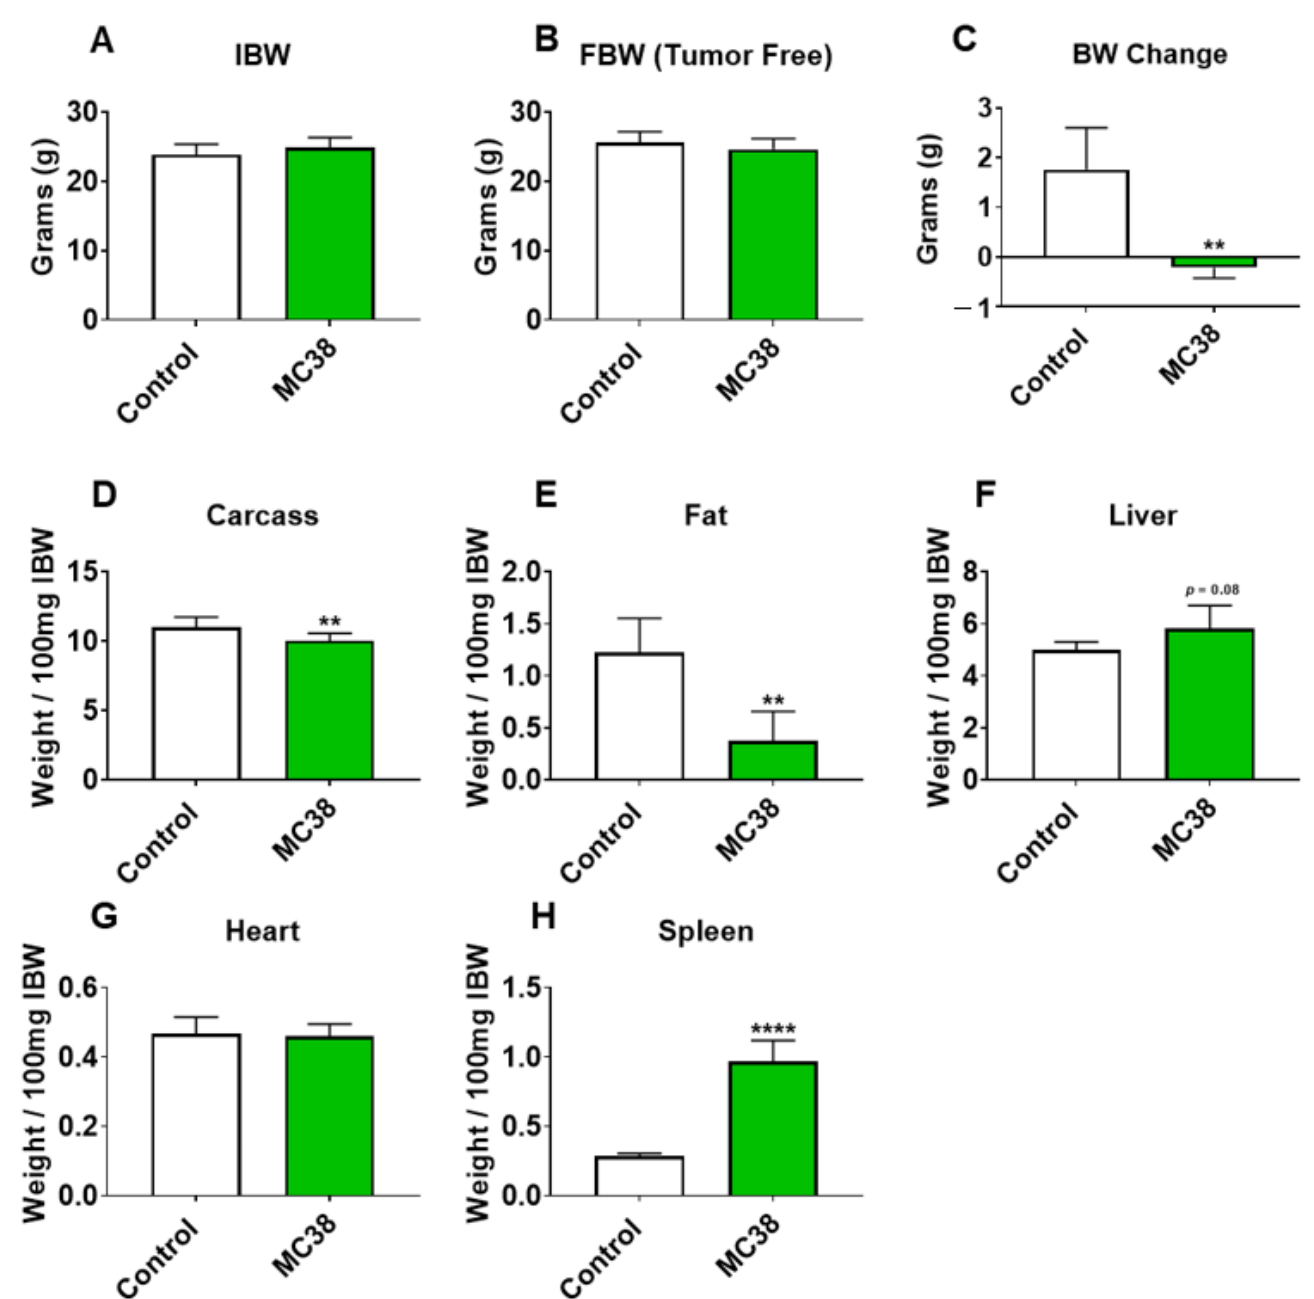
Figure 1. Growth of subcutaneous MC38 tumors promotes cachexia. ( A – D ) Initial body weight (IBW) ( A ), tumor-free final body weight (FBW) ( B ), BW change ( C ) and carcass weights ( D ) of C57BL/6 male mice (8 weeks) subcutaneously injected with MC38 tumor cells (1.0 × 10 6 cells/mouse in sterile PBS: MC38) or an equal volume of vehicle (control) ( n = 5). ( E – H ) Fat ( E ), liver ( F ), heart ( G ) and spleen ( H ) weights normalized to IBW. Data presented as mean ± s.d. ** p < 0.01, **** p < 0.0001 vs. control.